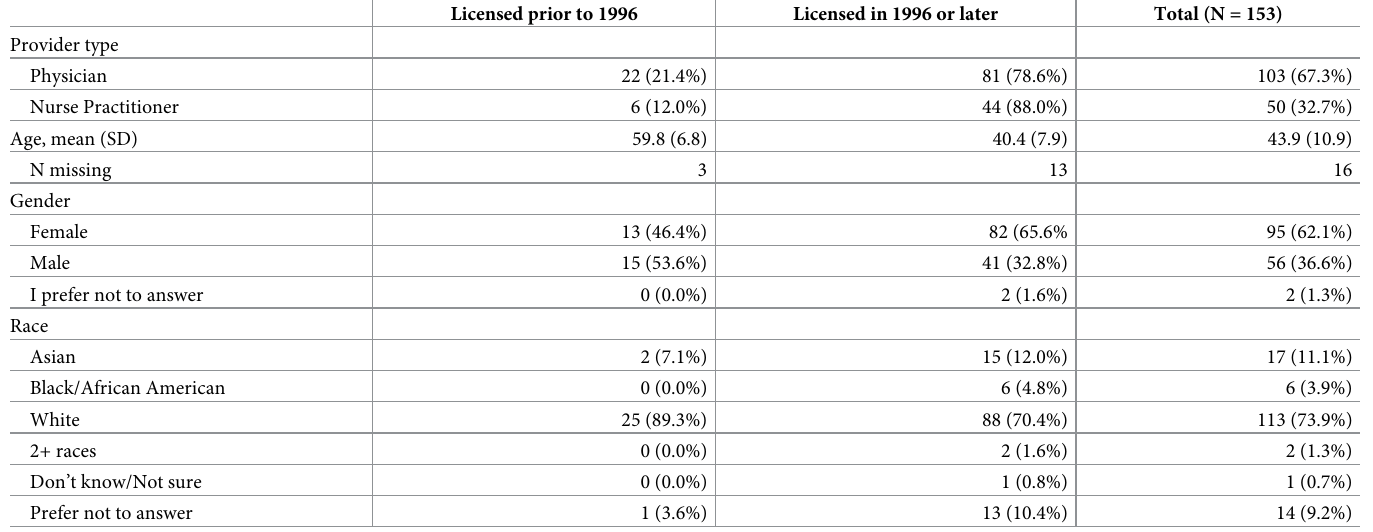
Table 3. Respondent